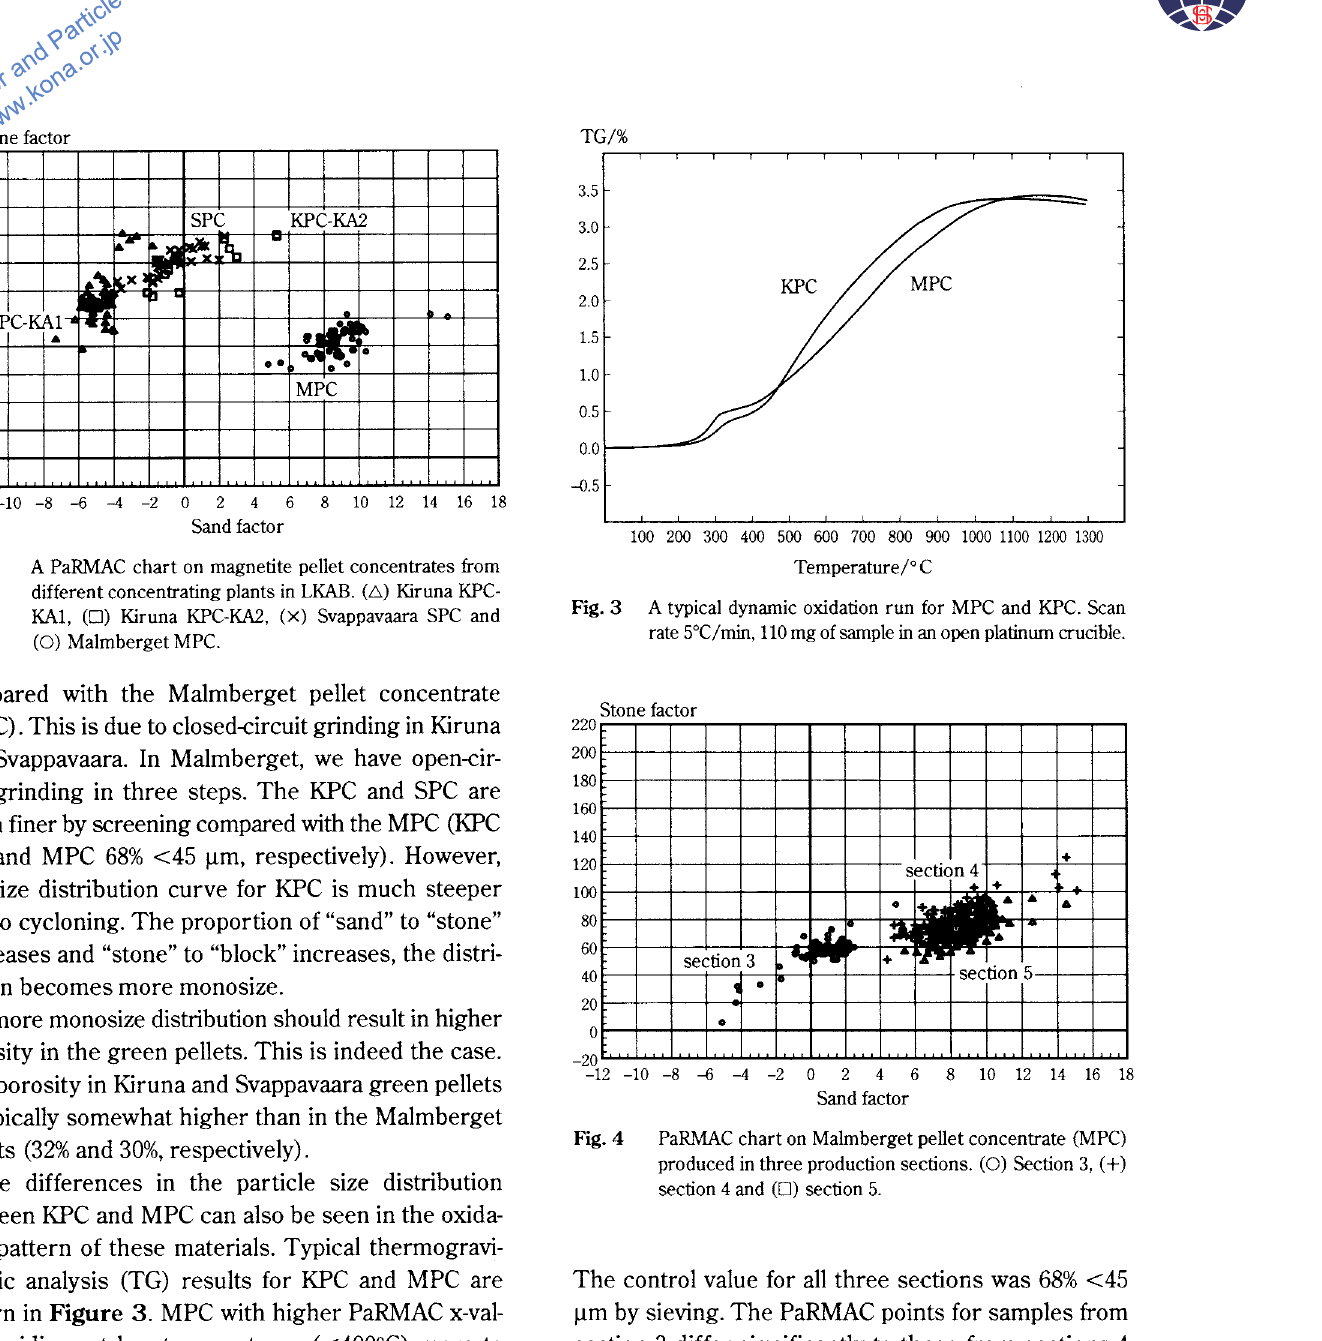
Fig. 4 PaRMAC chart on Malmberget pellet concentrate (MPC) produced in three production sections. (0) Section 3, ( +) section 4 and (D) section